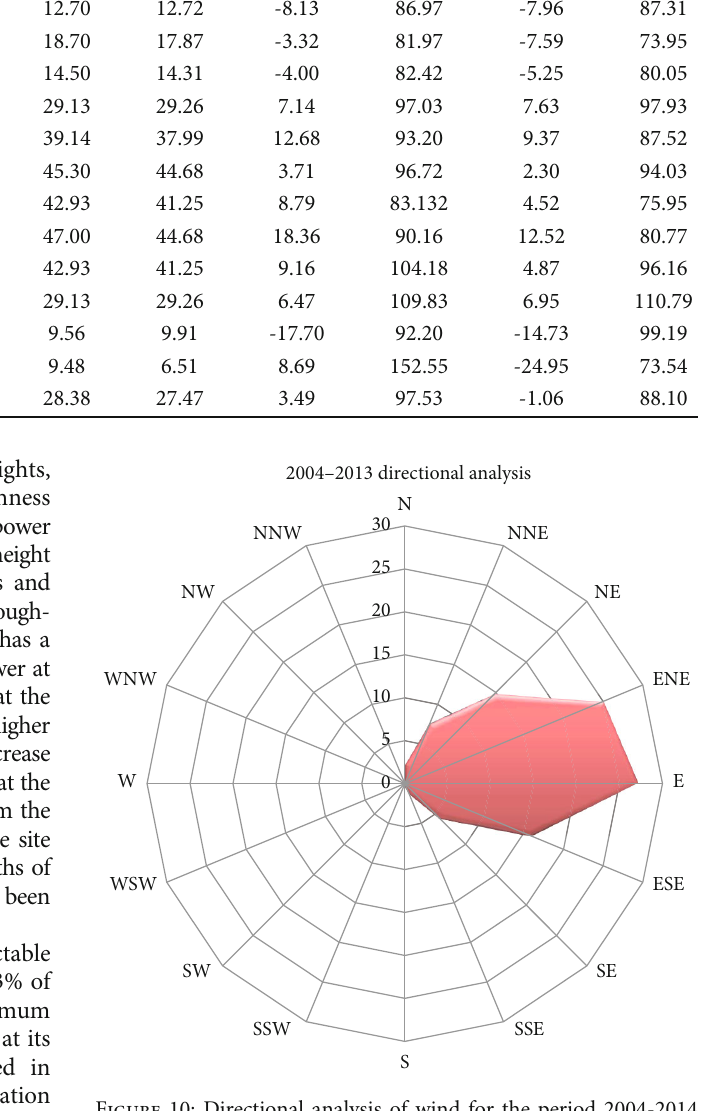
Figure 10: Directional analysis of wind for the period 2004-2014 (Tables 13 – 26 in Supplementary